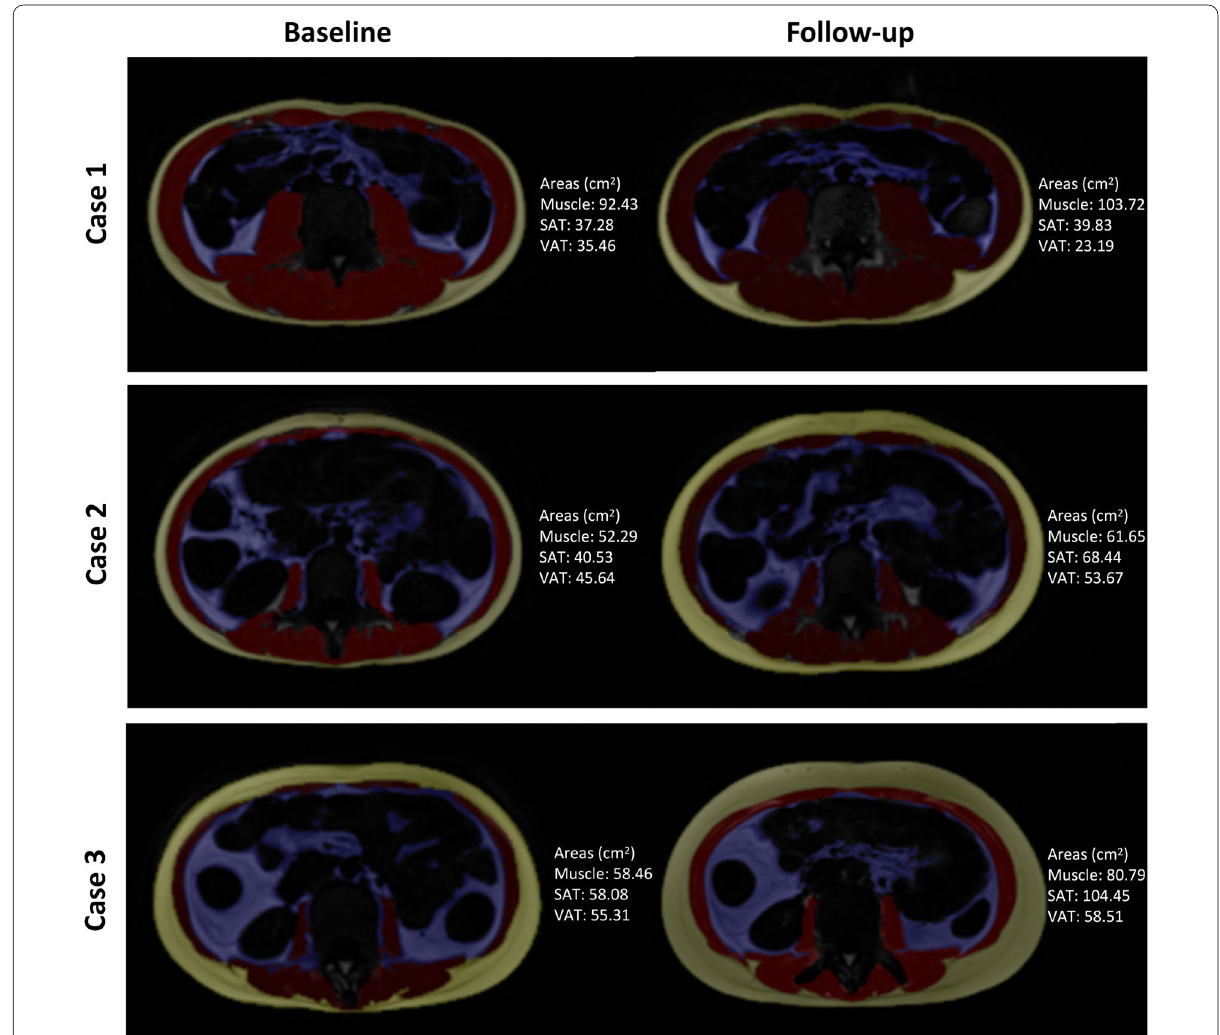
Fig. 5 Changes in body composition area during follow-up in three Crohn’s disease cases. The area of each component in these images has been labeled, and the changes in VA/TA index of case 1–3 is adipose tissue, VA/TA index: VAT to total adipose tissue ratio